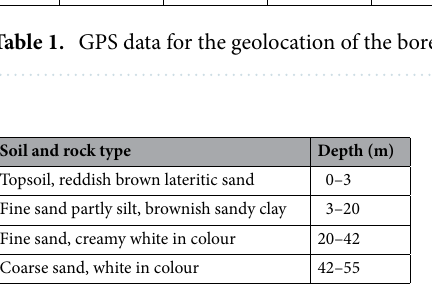
Table 2. Lithologic description of the borehole data obtained from the study